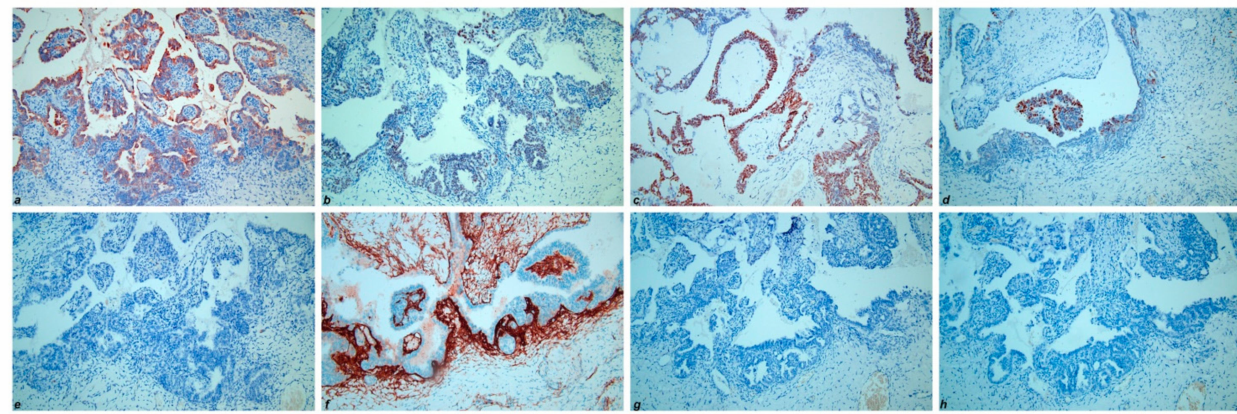
Figure 4. Immunohistochemical results of low-grade serous carcinoma component: ( a ) CK7; ( b ) PAX8; ( c ) ER; ( d ) PR; ( e ) Calretinin; ( f ) CD10; ( g ) TTF-1; ( h ) GATA-3. (200 × ).